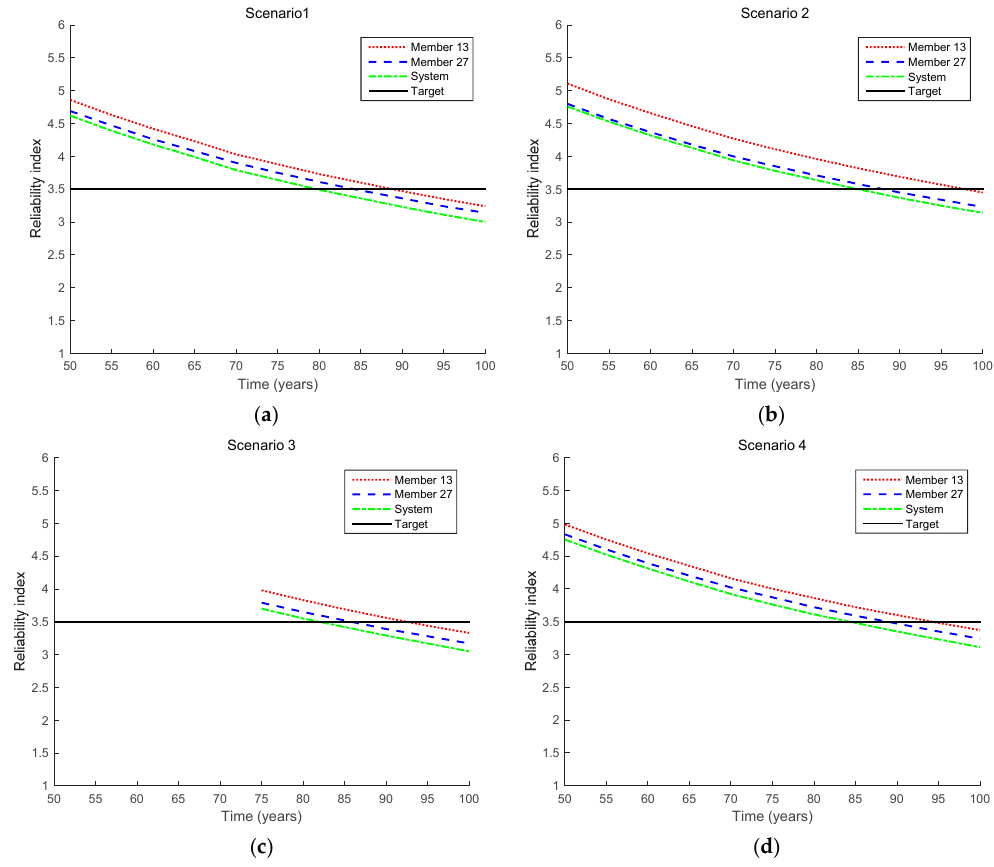
Figure 7. Reliability updating results by the proposed method for inequality cases (Scenarios 1–4 in Table 3 ). ( a ) Scenario 1; ( b ) Scenario 2; ( c ) Scenario 3; ( d ) Scenario 4.